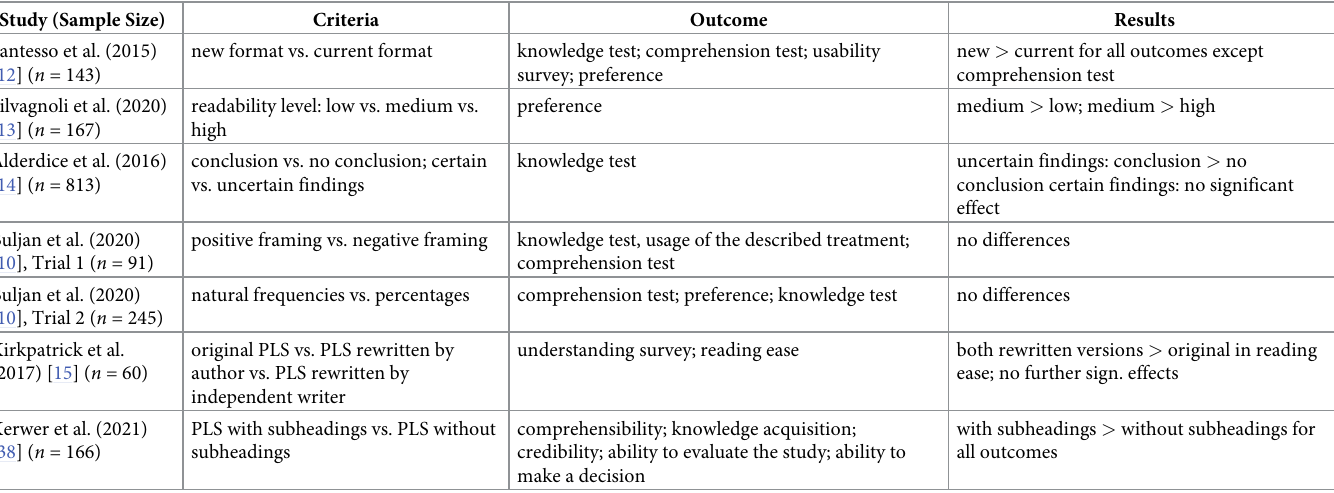
Table 3. Quantitative studies comparing PLSs with PLSs: Criteria, outcomes and